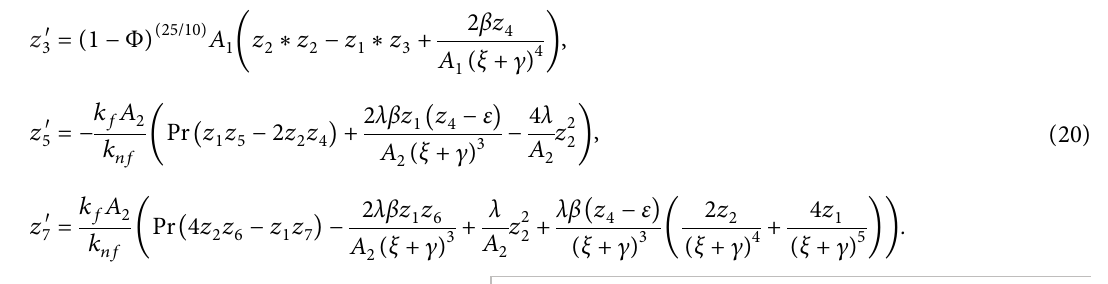
for ferrohydrodynamic parameter, Newtonian heating, and solid volume